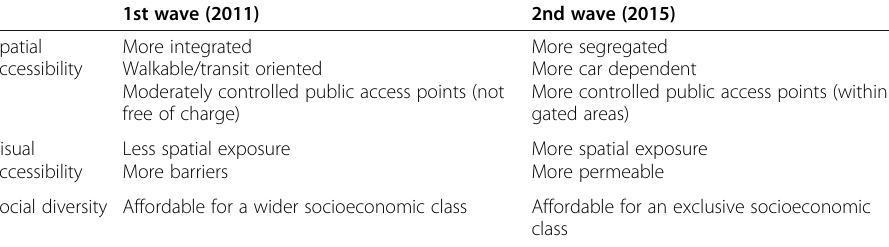
Table 3 Comparison between co-working space accessibility of the first and second waves. Source: elaboration by the authors Spatial accessibility